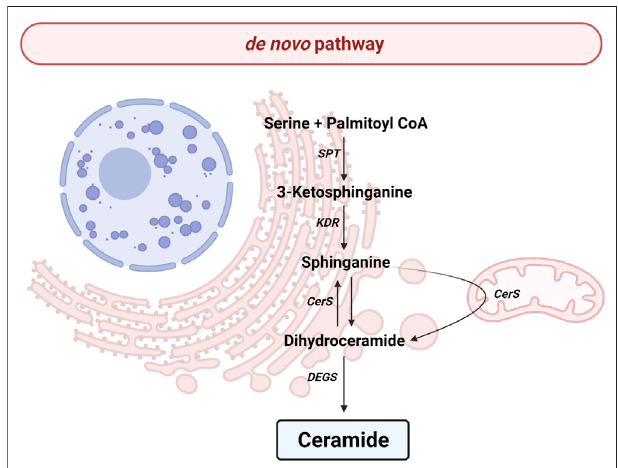
FIGURE 2 | de novo pathway. Solid arrows represent single reactions. Serine palmitoyltransferase (SPT), 3-keto-dihydrosphingosine reductase (KDR), Ceramide synthase (CerS) and dihydroceramide desaturase (DEGS) are represented by their